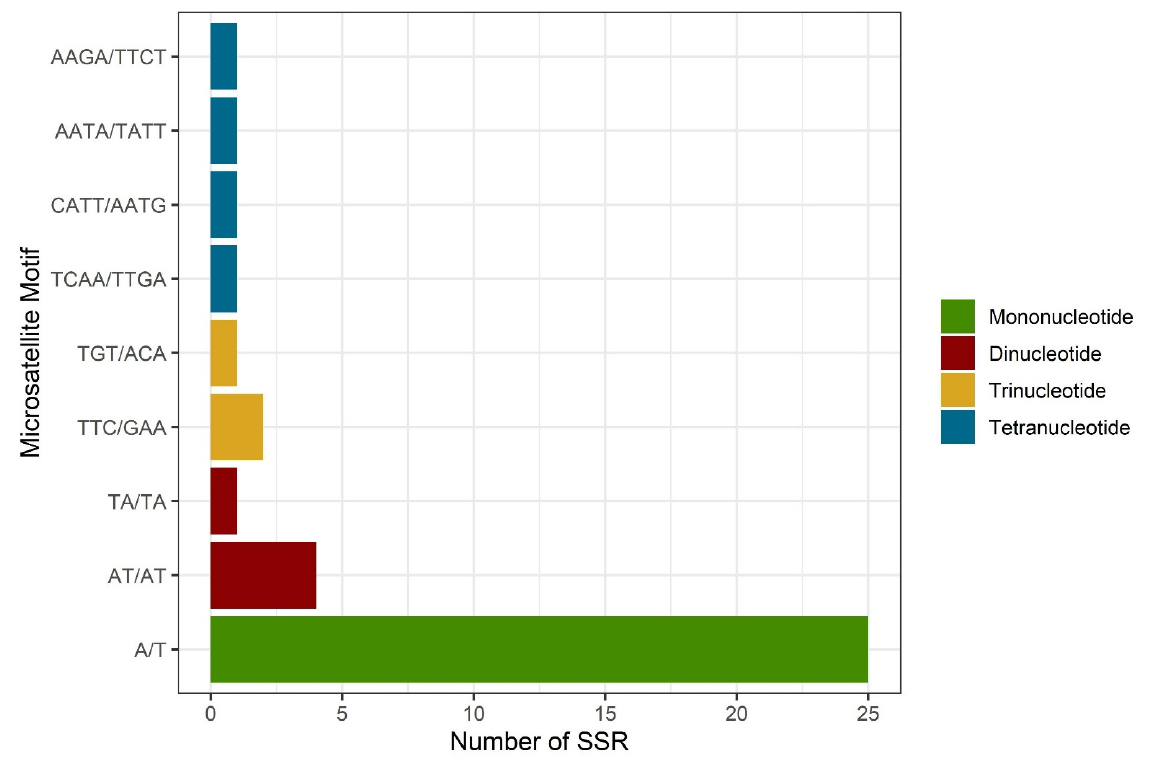
Figure 3. Analysis of simple sequence repeats (SSRs) distribution in C. spruceanum . The x -axis shows the number of SSRs. The y -axis shows SSR motif. The colored bars indicate the different repeats within SSRs.